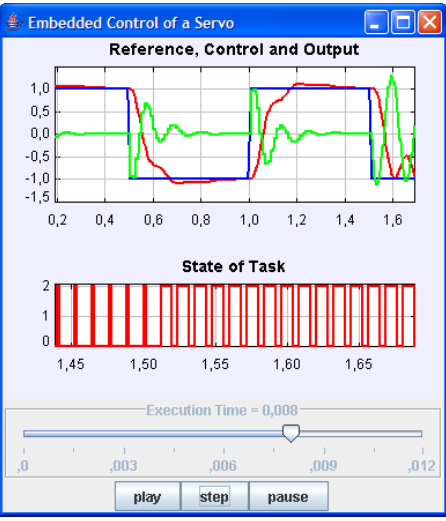
Figure 8. GUI of the virtual lab developed using the JTT-EJS